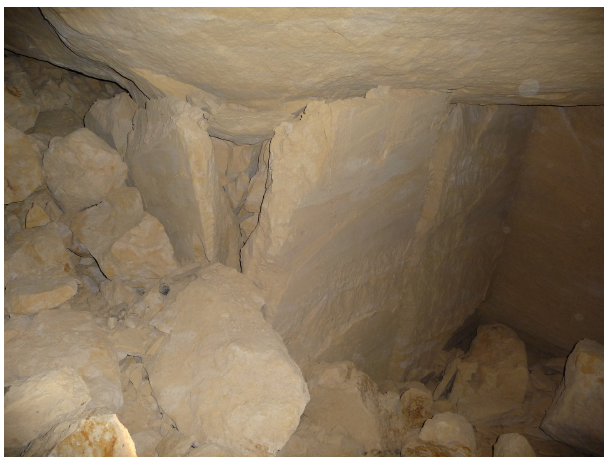
Figure 7. Collapsed pillar in the northeastern chamber of the lower mine system. The debris slope to the left gives access to this mine